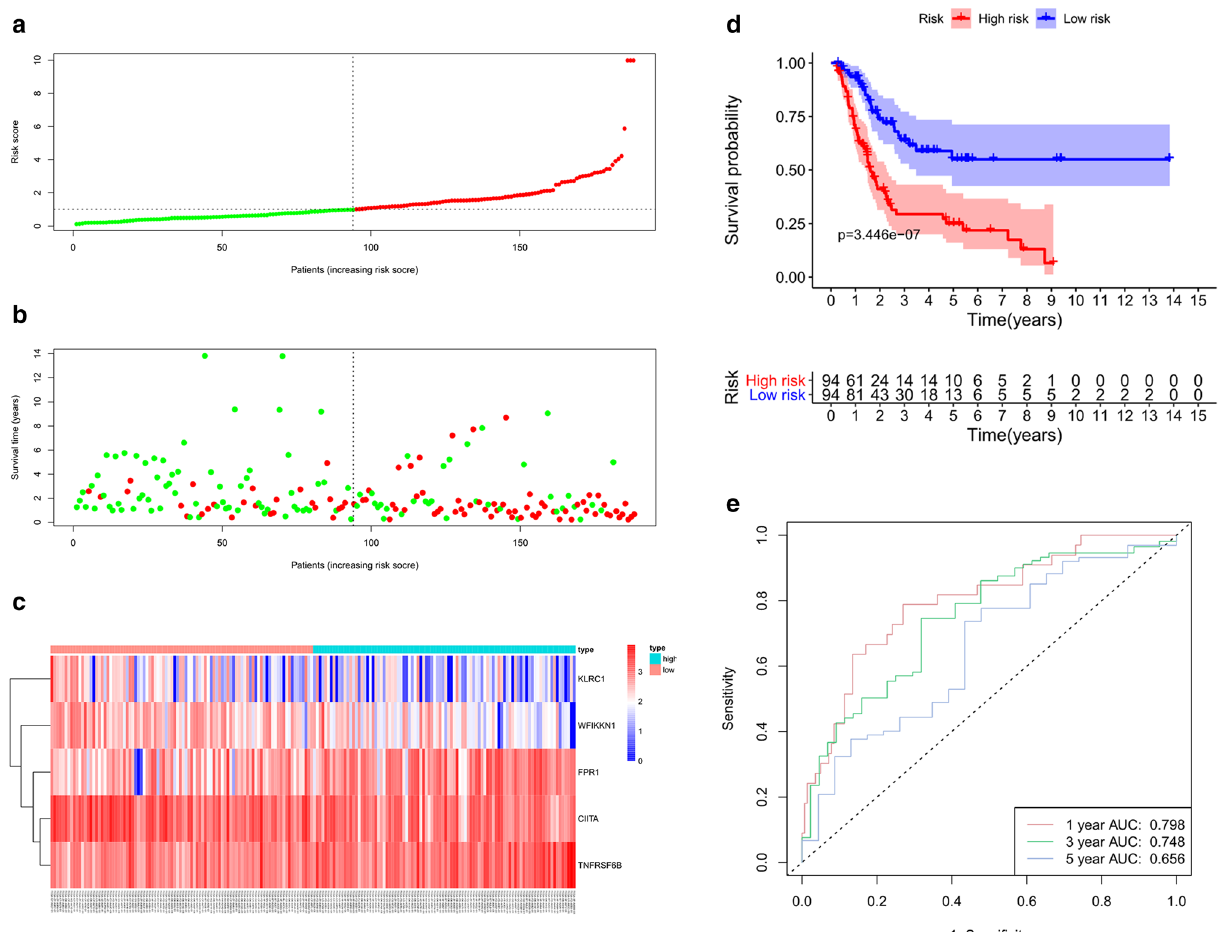
Figure 4. Evaluation of the prognosis prediction power of the five PIRMGs signature in the training group. ( a ) Distribution of risk score. ( b ) Survival status of BCa patients. ( c ) The expression profiles of the five PIRMGs. ( d